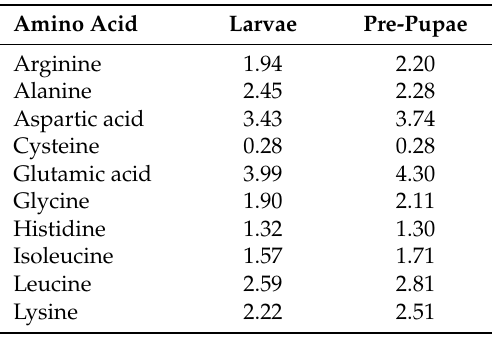
Table 3. Amino-acid concentration (% of dry matter) of black soldier fly larvae and pre-pupae. Amino Acid